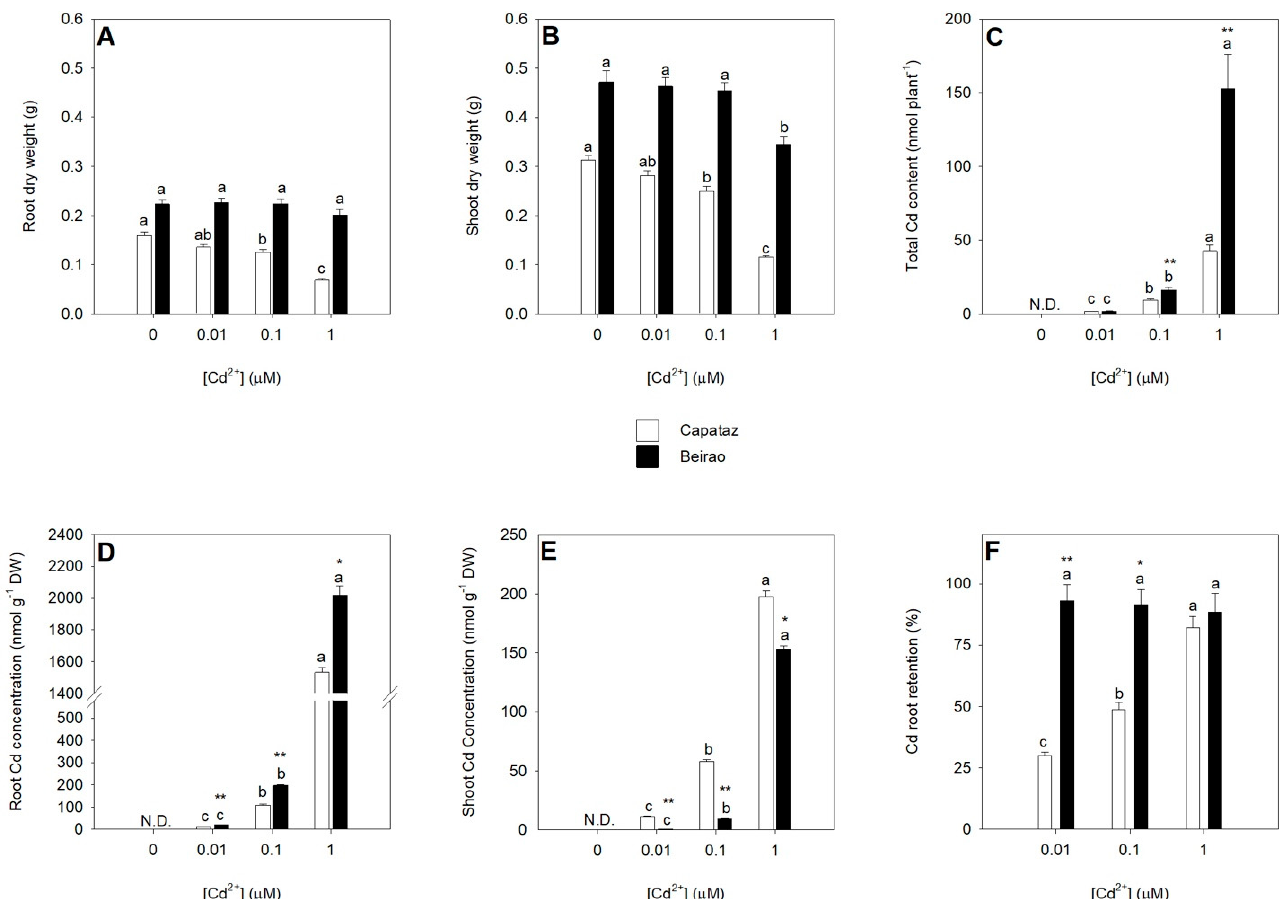
Figure 1. Plant growth under Cd stress and Cd partitioning between roots and shoots. Capataz (white bars) and Beirao (black bars) were exposed to different Cd concentrations (0.01, 0.1, and 1 μ M) for 10 days. Root ( A ) and shoot ( B ) dry weight. Total Cd content in a whole plant ( C ). Cd concentration in roots ( D ) and shoots ( E ). Cd root retention ( F ). Bars and error bars are means and SE of two experiments run in triplicate (n = 6). Different letters indicate significant differences among treatments ( p < 0.05). Asterisks indicate significant differences between Capataz and Beirao (Student’s t -test; * 0.001 ≤ p < 0.005; ** p < 0.001). DW, dry weight.